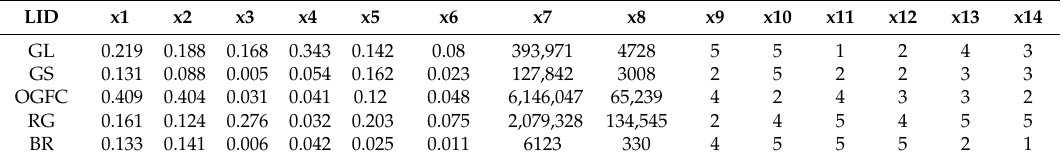
Table 3. Variables derived from the Case of Beijing Architecture